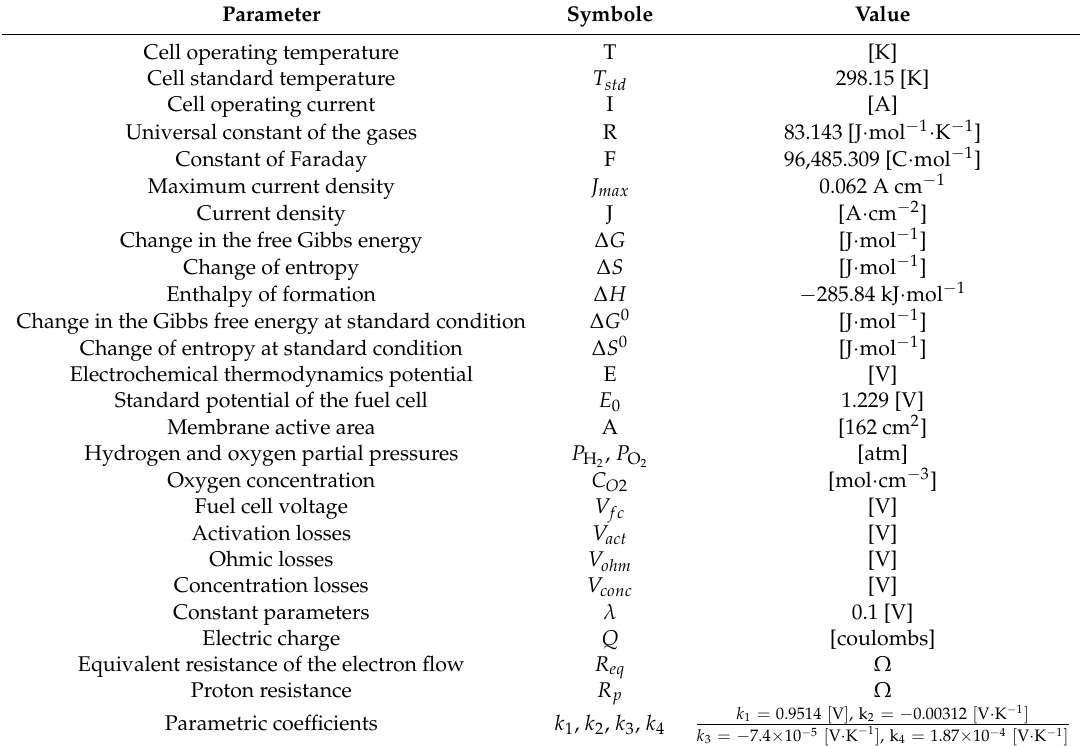
Figure 2. Ideal and actual V-I characteristics of the PEM fuel cell (PEMFC). Table 1. Parameter explanations of the PEMFC